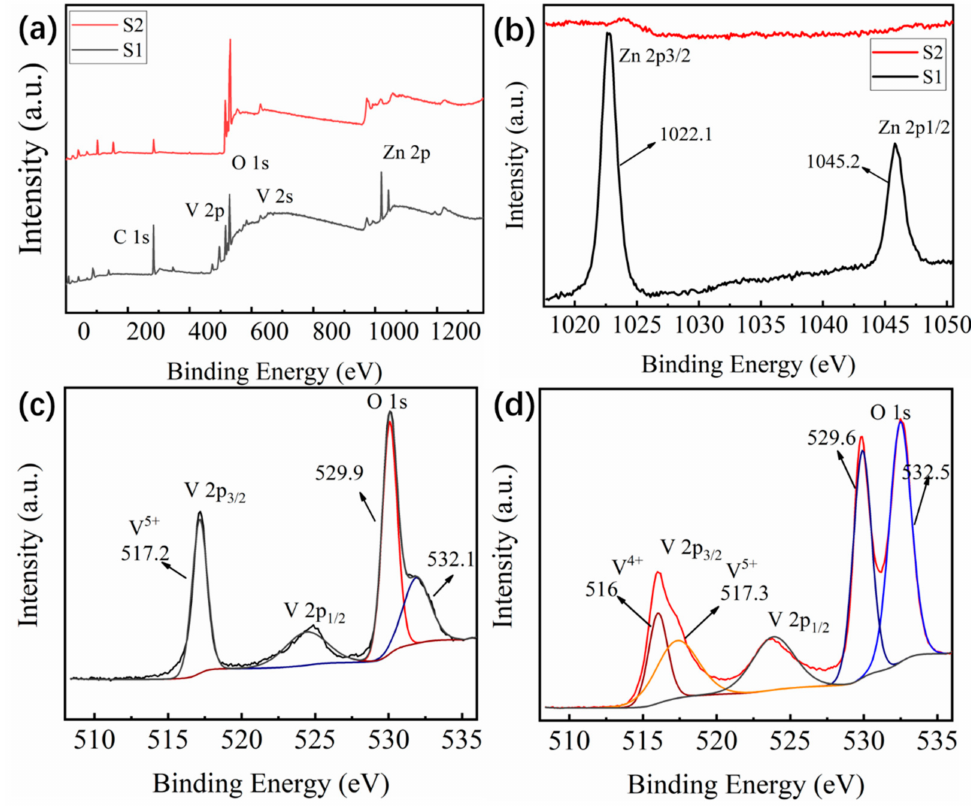
Figure 4. ( a ) XPS survey spectrum of samples S1 and S2, high-resolution XPS spectra for ( b ) Zn 2p, V 2p and O 1s core levels in ( c ) sample S1 and ( d ) sample